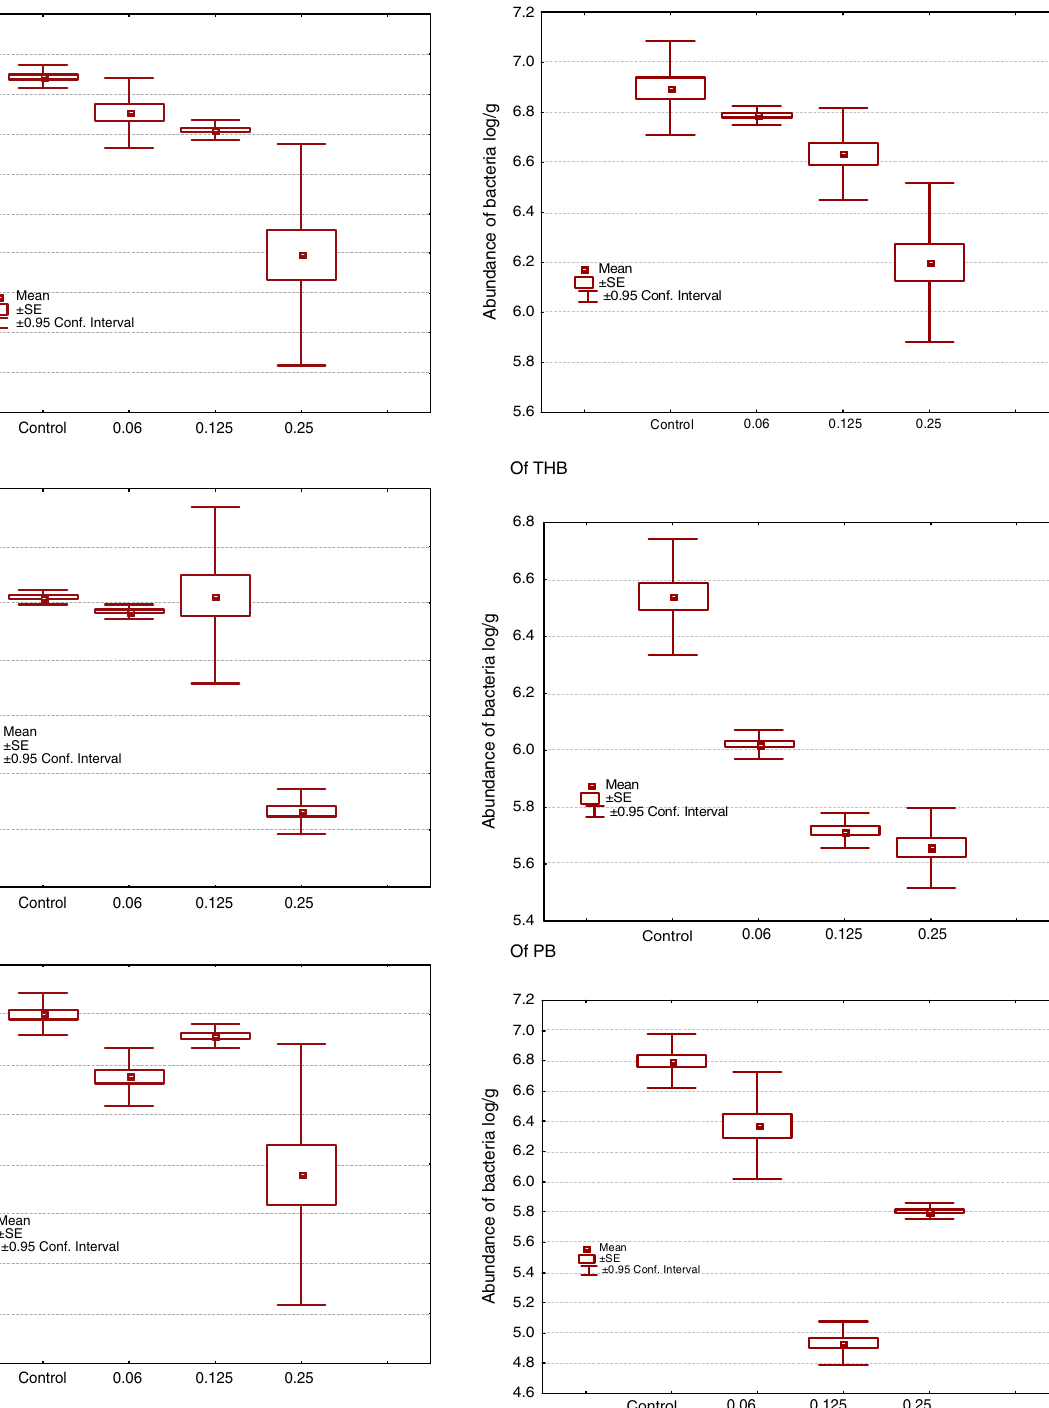
Fig. 3. The impact of the 96-hour exposure to the LC50 of Cu (cid:2) Zn ions mixture on abundance of bacteria in digestive tract of trouts after 8 days keeping fish in clean water Concentration in parts of equitoxic 96-hour LC50 mixture